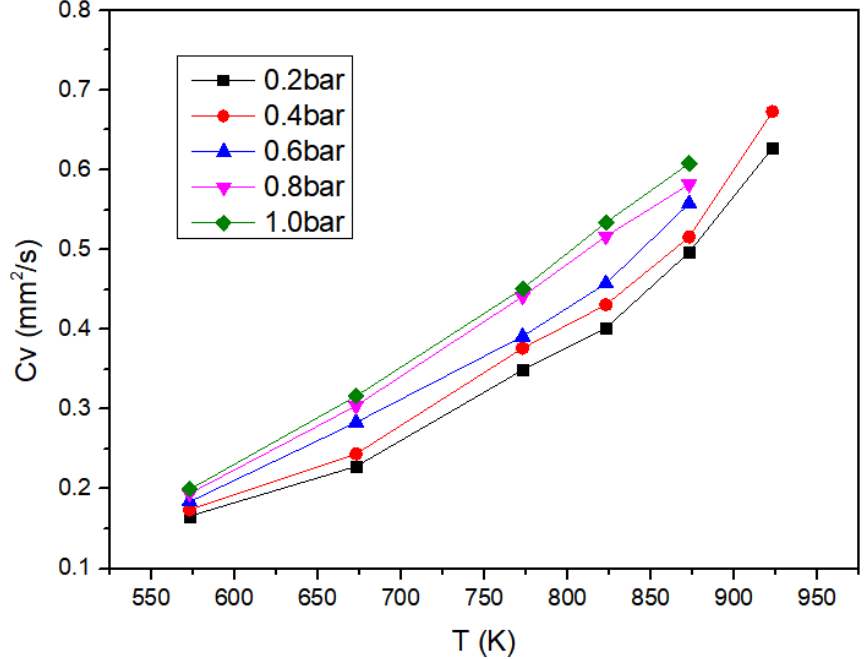
Figure 6. Influence of temperature on evaporation rates under different pressure conditions.